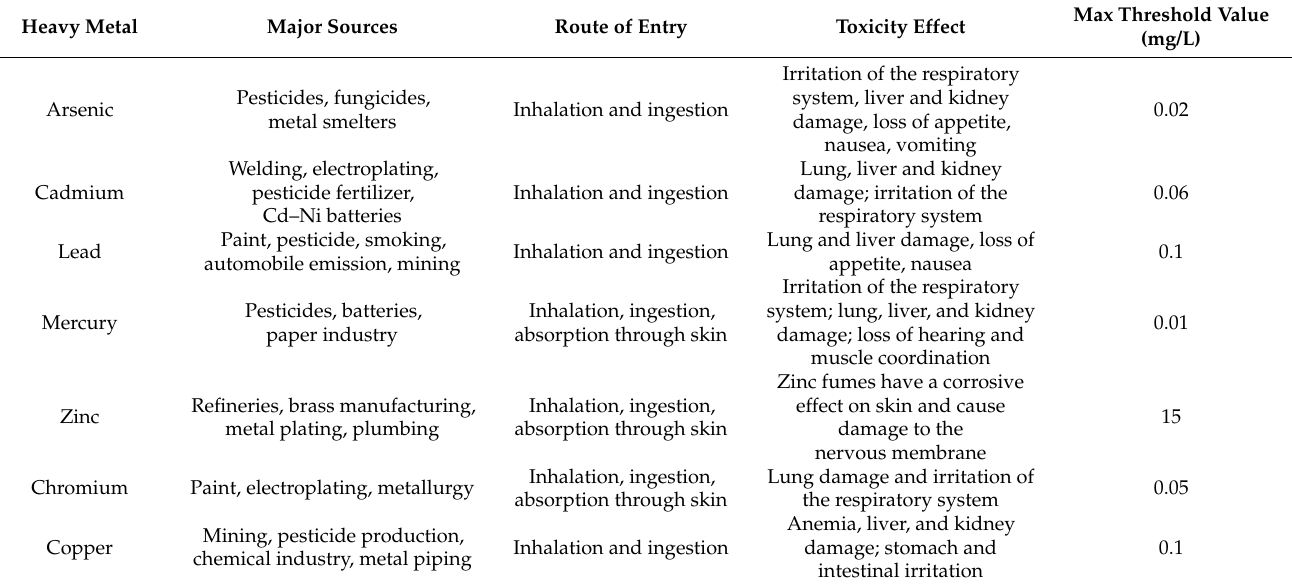
Table 1. Effects of heavy metals on human health and max threshold